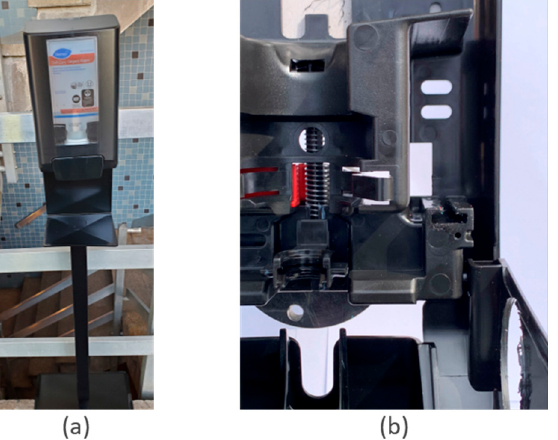
Figure 4. Existing sanitizer station with dispenser bottle (Diversey Intellicare Dispenser II, 1.3 L, 9.1 ″ × 19.5 ″ × 11.2 ″ ): ( a ) shows the dispenser with bottle installed as part of the sanitizer station; ( b ) inside view of the dispenser activation